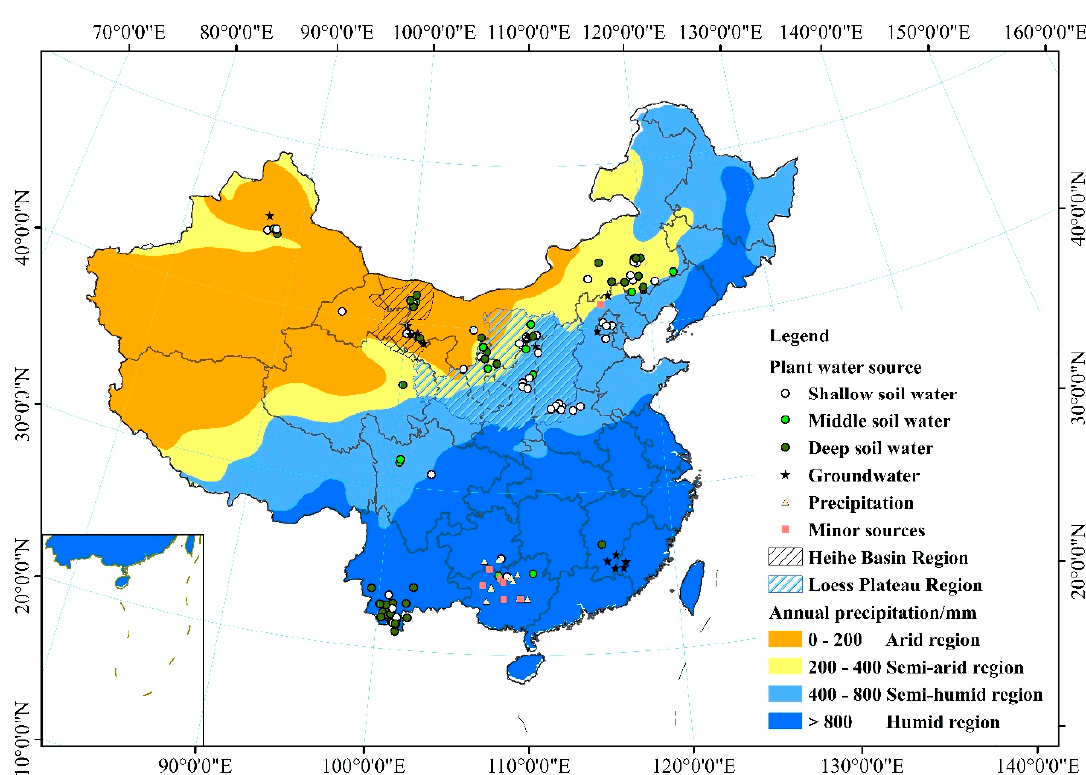
Figure 5. Plants’ main water sources in the dry season.